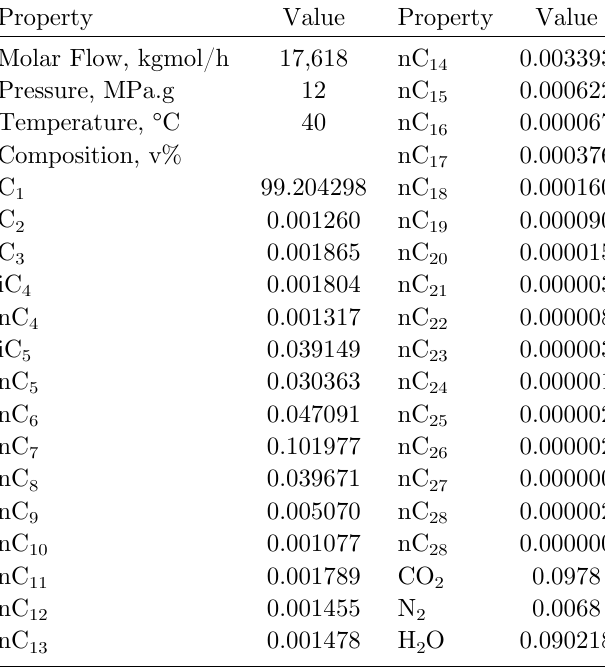
Table 2. Raw gas (inlet of dew point control unit) conditions and composition.